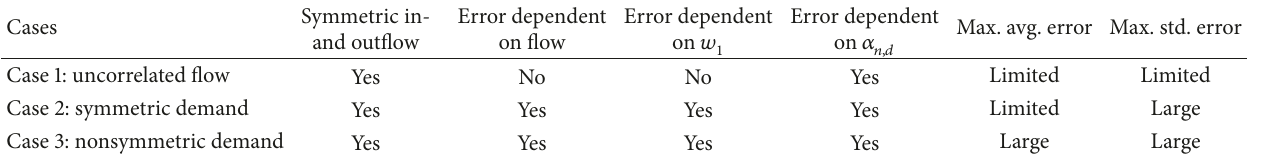
Table 1: Synthesis of the case